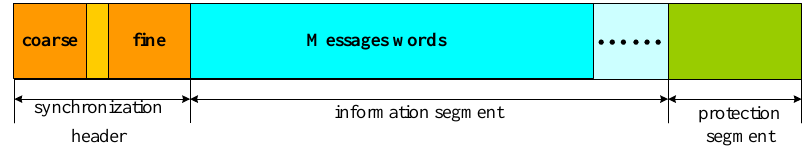
Figure 2. JTIDS message structure.